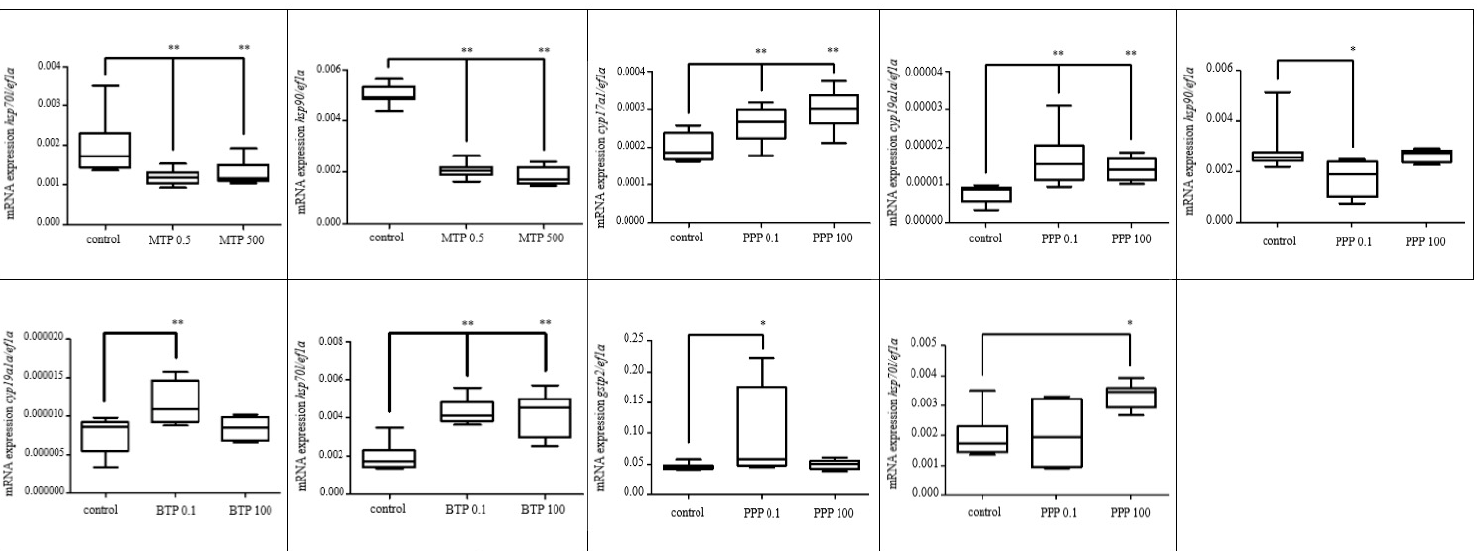
Figure 4. Relative mRNA expression of selected genes in D. rerio embryos exposed to various parabens. Concentrations are indicated in µg/L. Box plot graphs were constructed using median, Q1, and Q2 with whiskers of a maximum 1.5 interquartile range. Statistically significant differences are indicated by * ( p < 0.05) or ** ( p < 0.01).